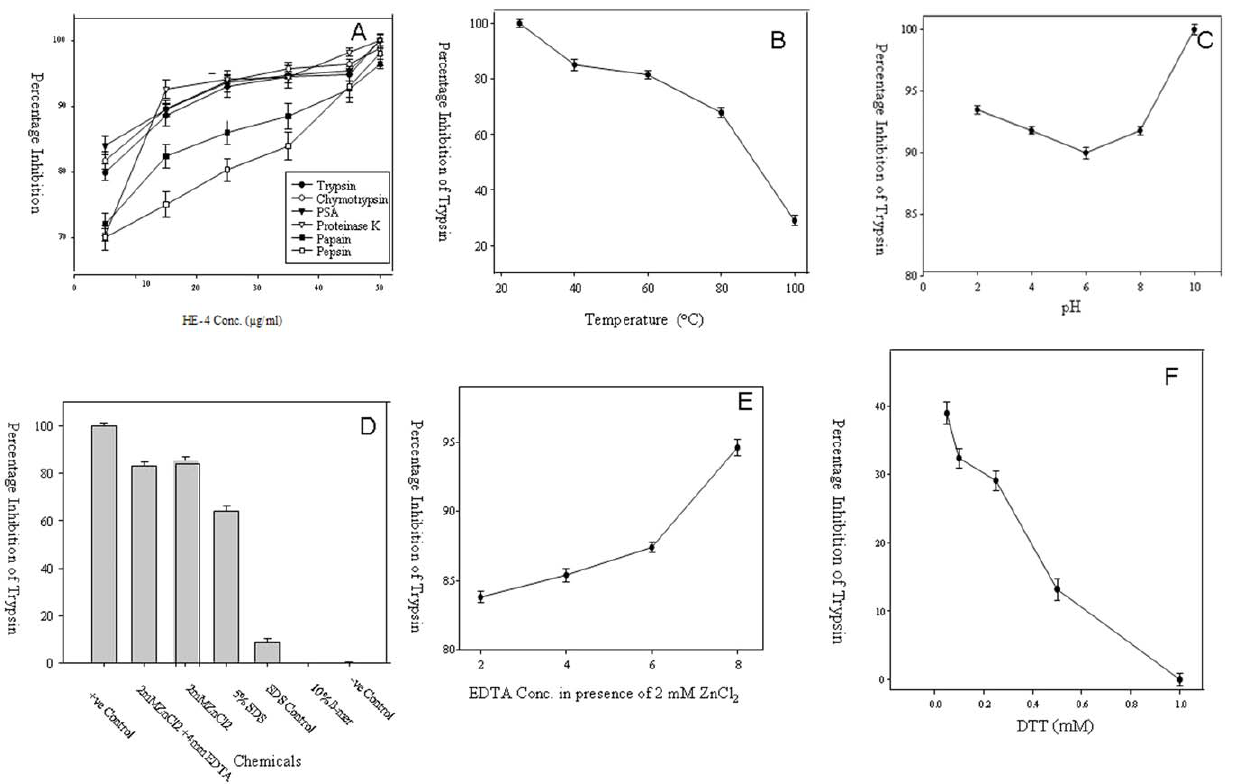
Figure 4. Antiprotease activity of HE-4 at different concentration and at different condition against various serine, cystine and aspartic proteases. ( A ) Percentage inhibition of various proteases like: trypsin, chymottrypsin, PSA, proteinase K, pepsin and papain by HE-4. X-axis is the HE-4 concentration in m g/ml and Y-axis is the % inhibition of respective proteases. ( B ) Effect of temperature (25 u C–100 u C) on the protease inhibition activity of HE-4 against trypsin. ( C ) Effect of pH (2–10) on the protease inhibition activity of HE-4 against trypsin. ( D ) Effect of different chemicals like: ZnCl 2 SDS and b -mercaptoethanol on the protease inhibition activity of HE-4 using trypsin as model protease. EDTA was added to ZnCl 2 pre-treated HE-4 to check whether it can rescue the decrease in activity induced by ZnCl 2. SDS control is the % inhibition of trypsin by 5% SDS and 5% SDS point is the activity of SDS-pretreated HE-4 against trypsin. + ve control is HE-4 inhibition of trypsin without any treatment and 2 ve control is without HE-4, therefore 0% inhibition. ( E ) Effect of varying concentrations of EDTA on rescue of trypsin % inhibition decrease by ZnCl 2 treatment of HE-4. ( F ) Effect of varying concentration of DTT on trypsin inhibitory activity of HE-4.